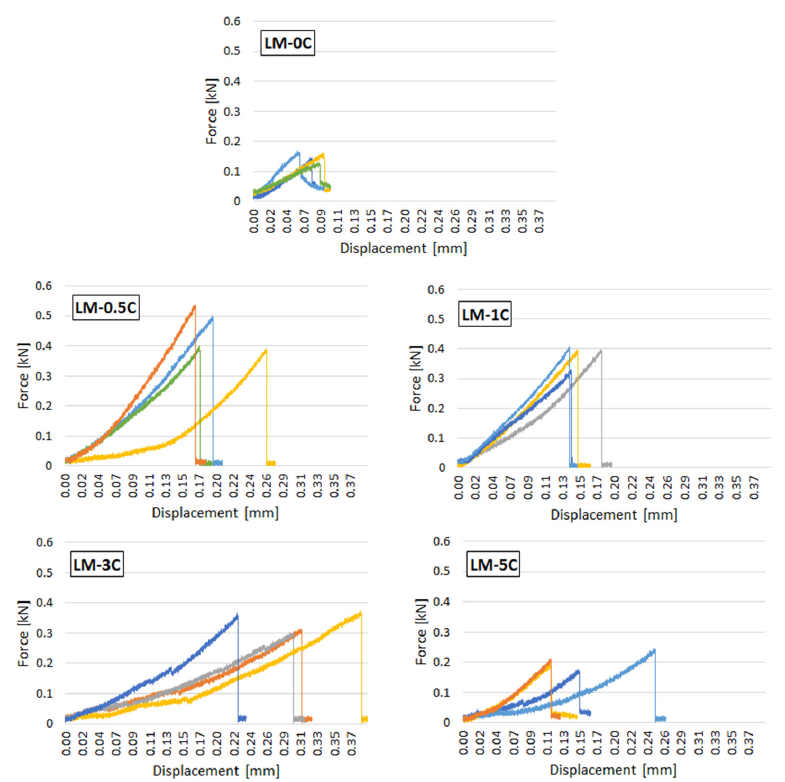
Figure 6. The dependence of the bending force on the press head displacement. The relationships between the stress and the strain of all samples within an individ- ual recipe are shown in Figure 7.